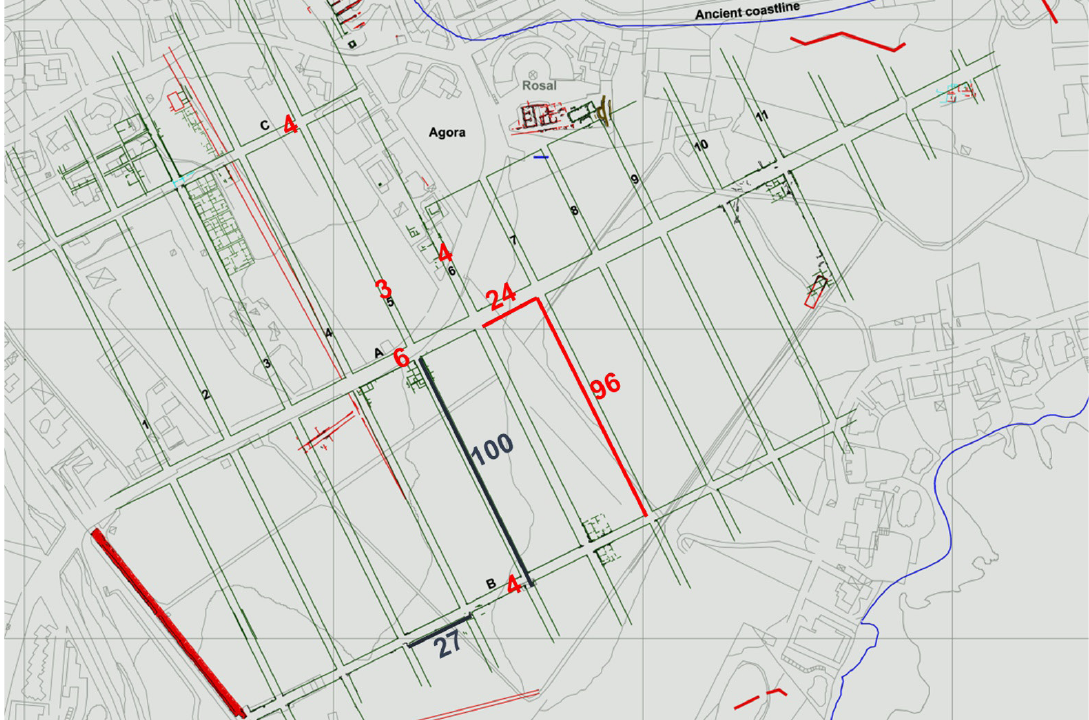
Figure 11. Classical city grid of Naxos. Principal dimensions expressed in terms of design module. Based on cosine quanto- gram analysis of the topographical survey measurements (Jari